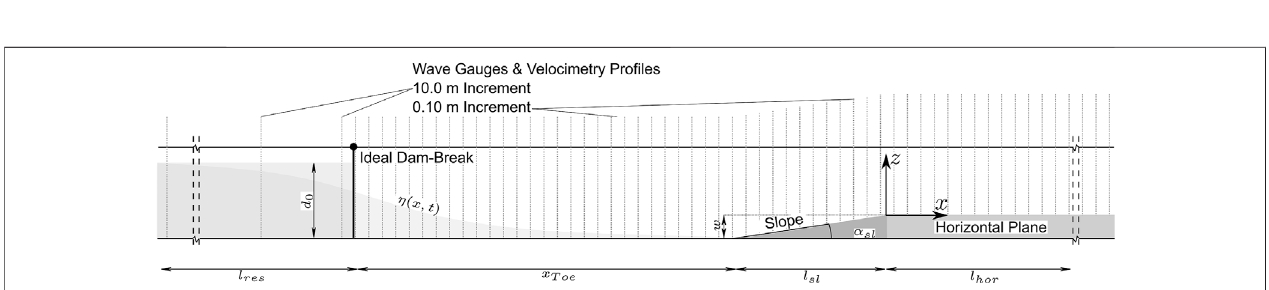
FIGURE5| Side-viewsketchofthenumerical fl ume.Wavegaugesandvelocimetrypro fi lersareplacedovertheentiredomainwithaspacingof0 . 10 m and10 . 0 m . Thefreesurfacepro fi leisindicatedby η ,thelengthofthereservoir l res ,theconstantlengthofthehorizontalplane l hor (cid:1) 10 m ,thelength l sl andtheheight w oftheslope, the distance between the initial water column and slope x Toe , and the initial impoundment depth d 0